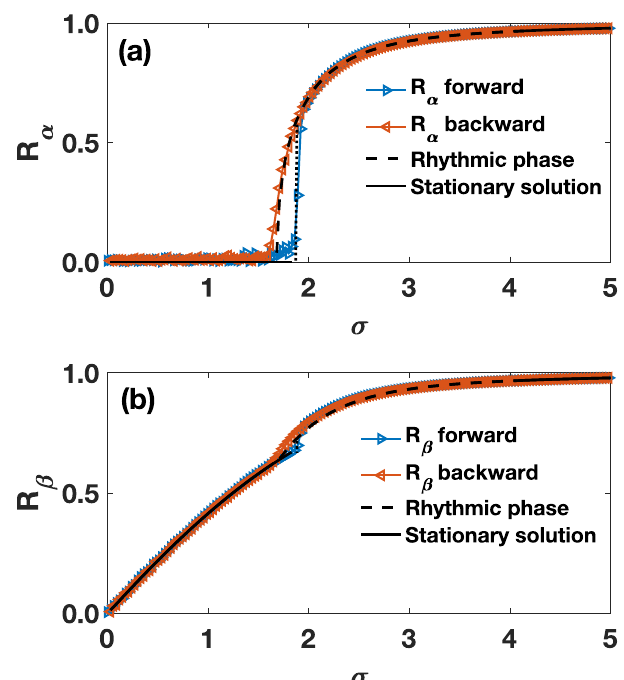
Fig. 3 The phase diagram of Dirac synchronization: Numerical results and theoretical expectations. The forward and backward Dirac synchronization transitions of the real order parameters R α ( a ) and R β ( b ) are plotted as a function of the coupling constant σ . The numerical results are obtained for a network of N = 20,000 nodes, by integrating the dynamical equations with a 4th order Runge-Kutta method with time step Δ t = 0.005 where, for each value of σ the dynamics is equilibrated up to time T max ¼ 10. The coupling constant σ is adiabatically increased and then decreased with steps of size Δ σ = 0.03. For each step in σ , the plotted values of the real order parameters are averaged over the last fi fth of the time series. Black lines indicate the theoretical predictions as developed in Eqs. (67). Solid lines indicate steady state solutions of the continuity equations and dashed lines represent theoretical predictions in the non-stationary coherent phase. The discontinuous transition point occurs at a coupling strength below the theoretical estimate due to fi nite-size effects. We show with the dotted line the location of the onset of the instability as extracted from fi nite size scaling corresponding to the network size N = ð N Þ < 2 : 14623 ::: in fi nite networks. We study this observed at σ ? c effect quantitatively by measuring the transition threshold on systems of varying size N , averaging 100 independent iterations for each N (see Fig. 4). We fi nd that the observed distance from the theoretical critical point given in Eq. (31) decreases consistently with a power-law in N, with scaling exponent ¼ 5), con fi rming 0.177 (computed with integration time T max further our theoretical prediction of σ ? . The observed behavior is c consistent with the earlier transition being caused by fi nite N effects. For fi nite N , the system will have fl uctuations about the incoherent state which may bring the system to the basin of attraction of the rhythmic phase and cause a transition even when the incoherent state is stable. Thus, the observed transition point depends on N (larger N implies smaller fl uctuations), and T max (larger T implies larger probability of transition before max reaching σ (cid:5) ). c